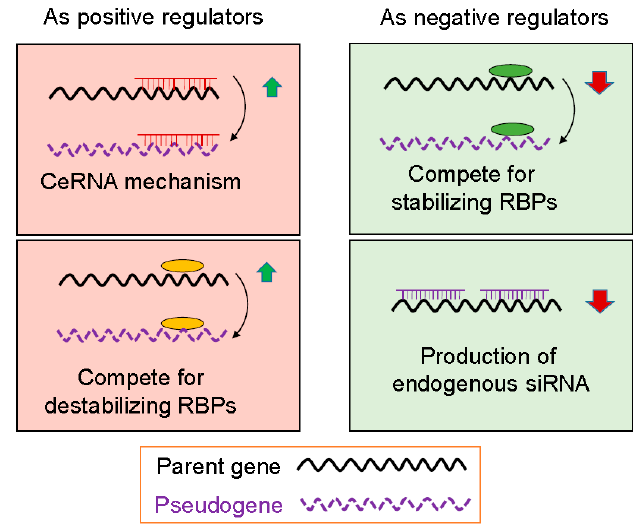
Figure 2. Possible mechanisms of pseudogene-mediated gene regulation. As positive regulators, pseudogenes may compete microRNA response elements (MREs) with the parent genes for the same microRNAs or same destabilizing RNA binding proteins (RBPs). As a result, levels of the parent genes are increased. As a negative regulators, pseudogenes may compete the same stabilizing RBPs with the parent genes, leading to downregulation of parent genes. Alternatively, pseudogenes may transcribe into endogenous siRNAs that can bind to any region of the parent genes, and suppress expression of the parent genes.